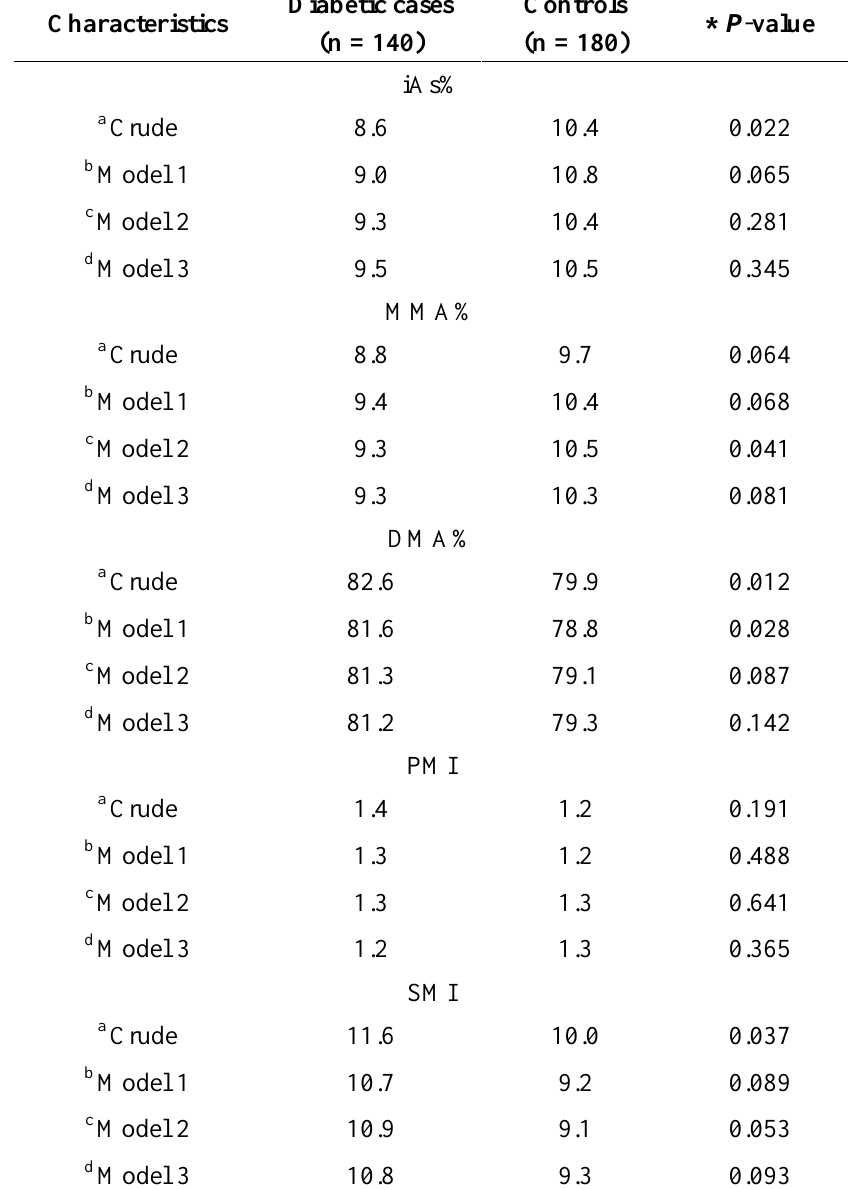
Table 3. Adjusted means of urinary inorganic arsenic, its metabolites and methylation indexes in cases and